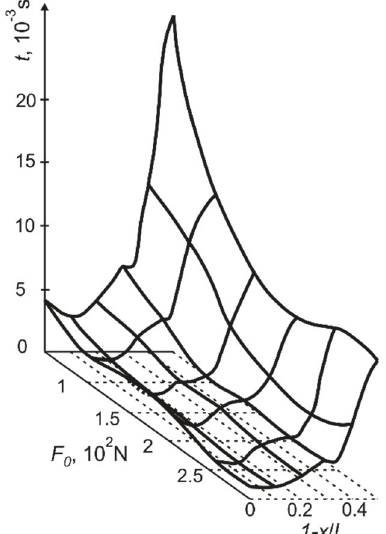
Figure 12. Dependence of vibro-impact motion time on the position of the support 1- x / l (distance of the support from the free end of the cantilever) and the pre - stress F 0 of the cantilever on the